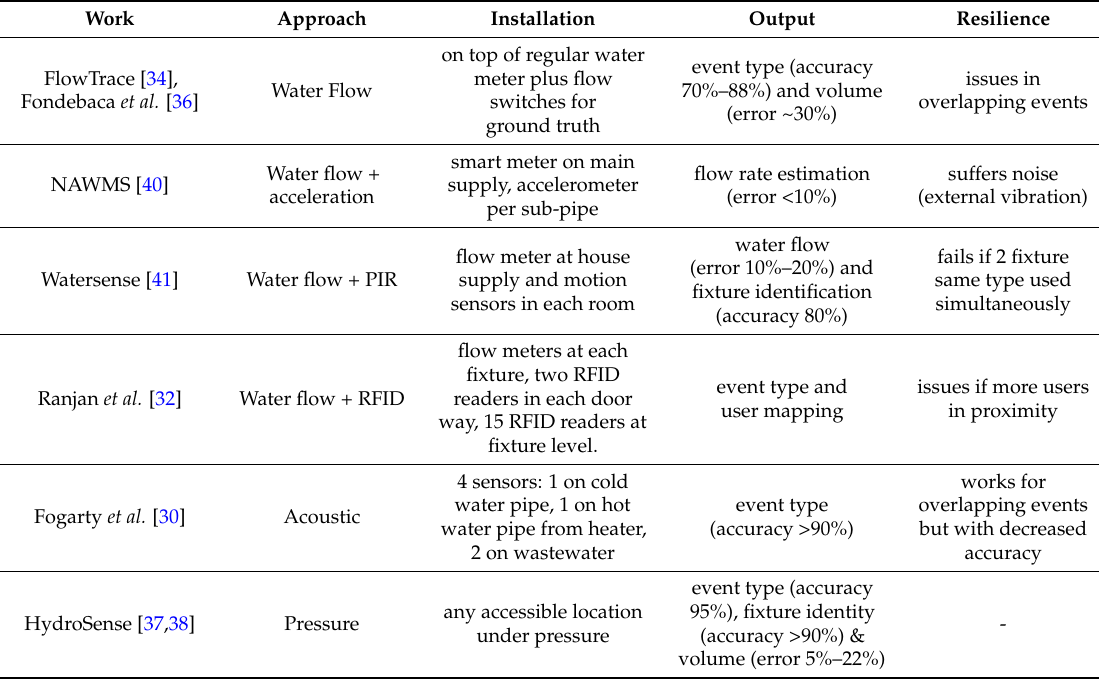
Table 3. Summary of approaches and their characteristics in terms of output, resilience and